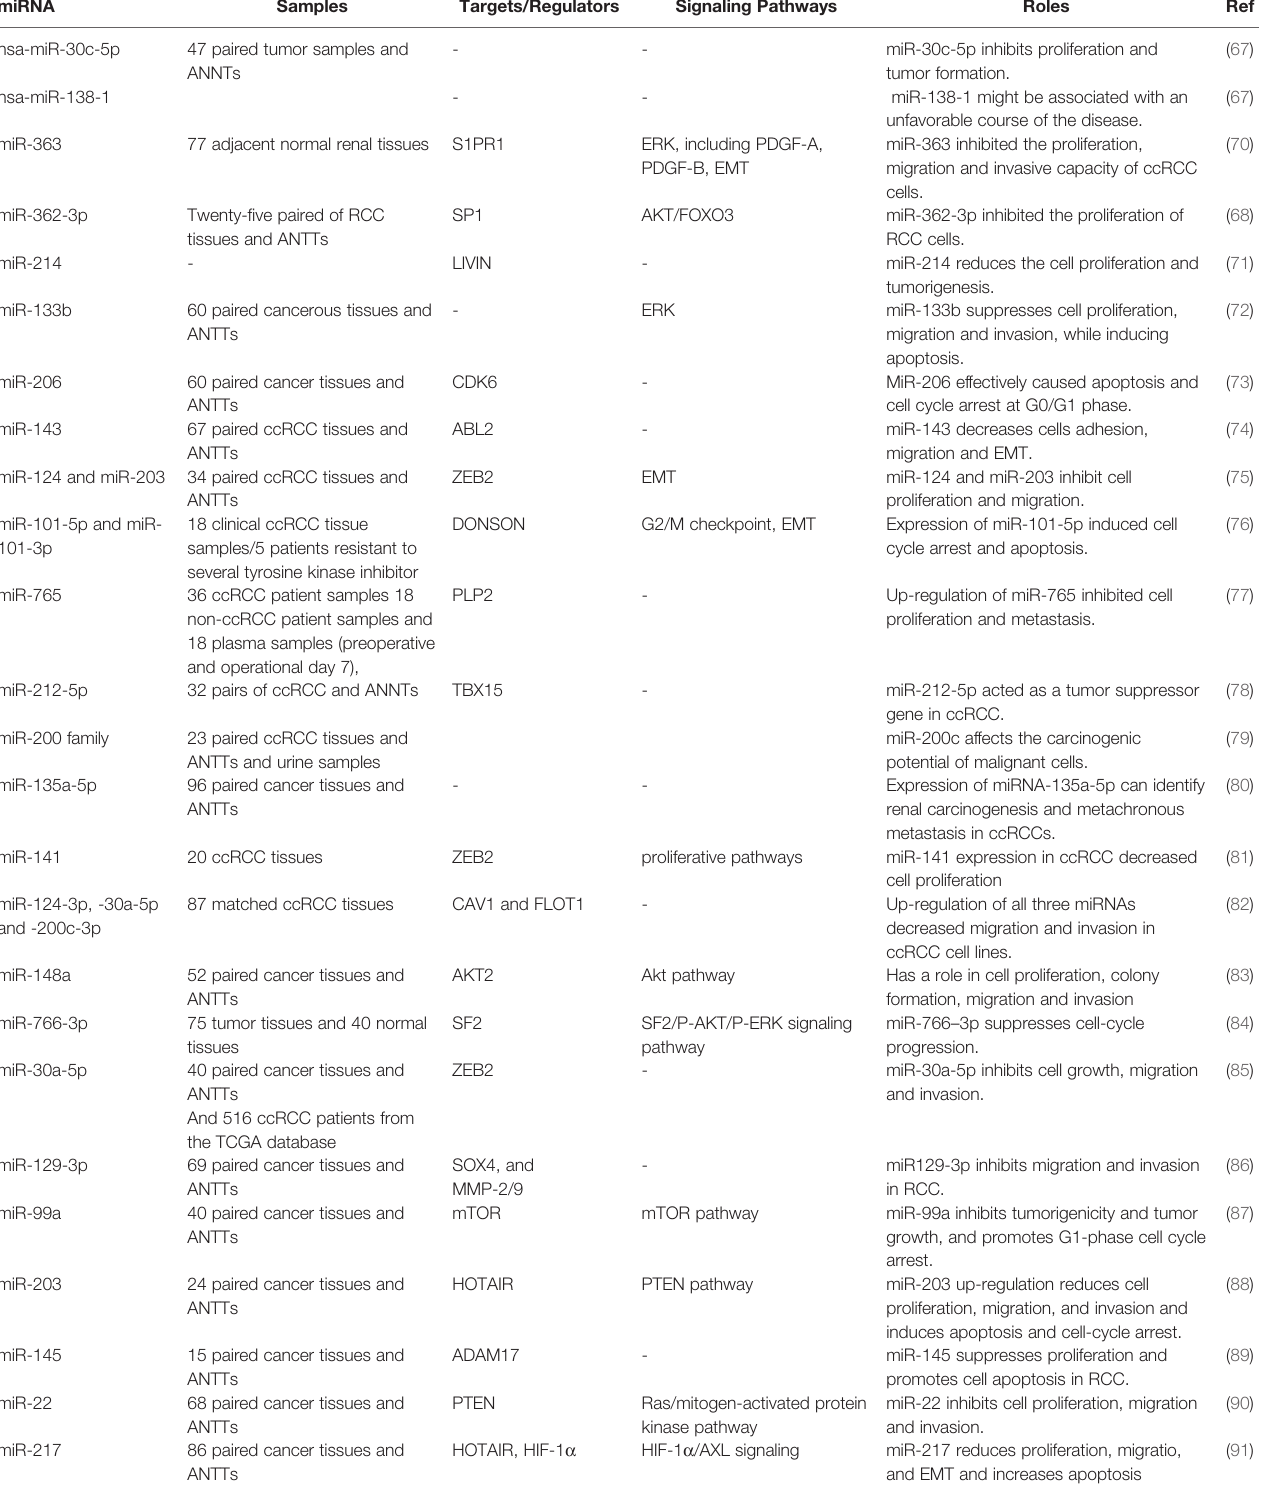
TABLE 2 | Tumor suppressor miRNAs in RCC.